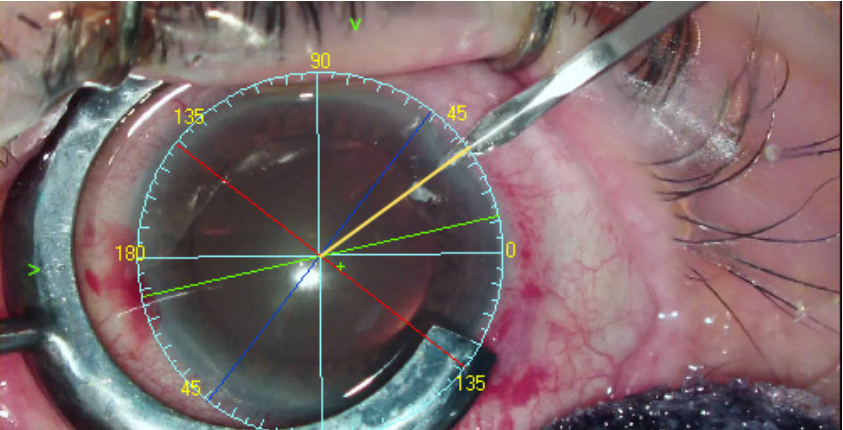
Figure 4. The INTEGRA system operation view: Blue lines and yellow numbers—TABO scale. Green cross—visual axis. Green arrows indicates the visual axis (not INTEGRA view), Dark blue line—flat meridian. Red line—steep meridian. Yellow line—main incision suggestion. Green line—intraocular lens implantation axis.